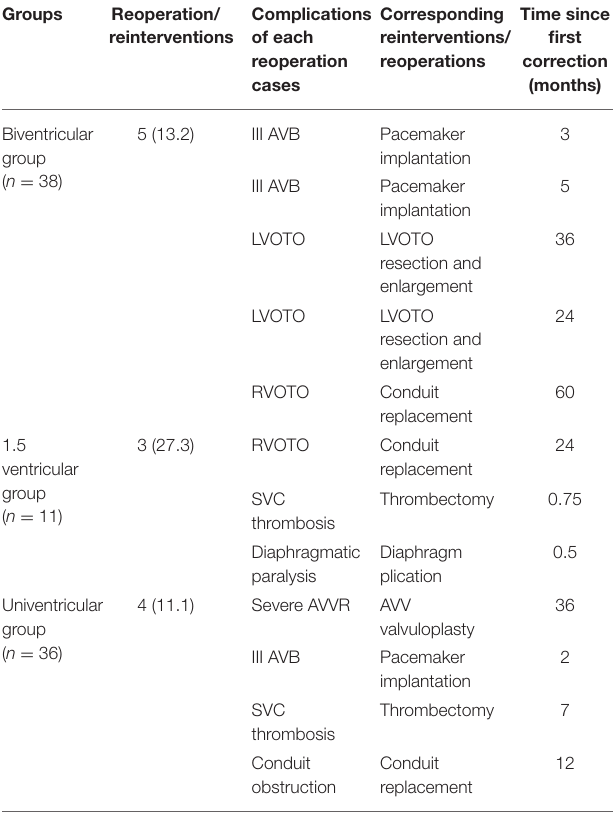
TABLE 3 | Short-to mid-term complications and reinterventions associated with each patient.